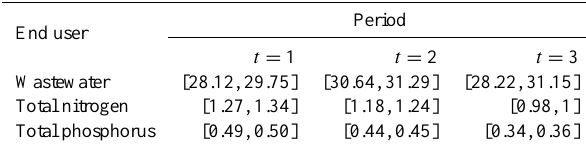
Table 6. Water pollution control (10 3